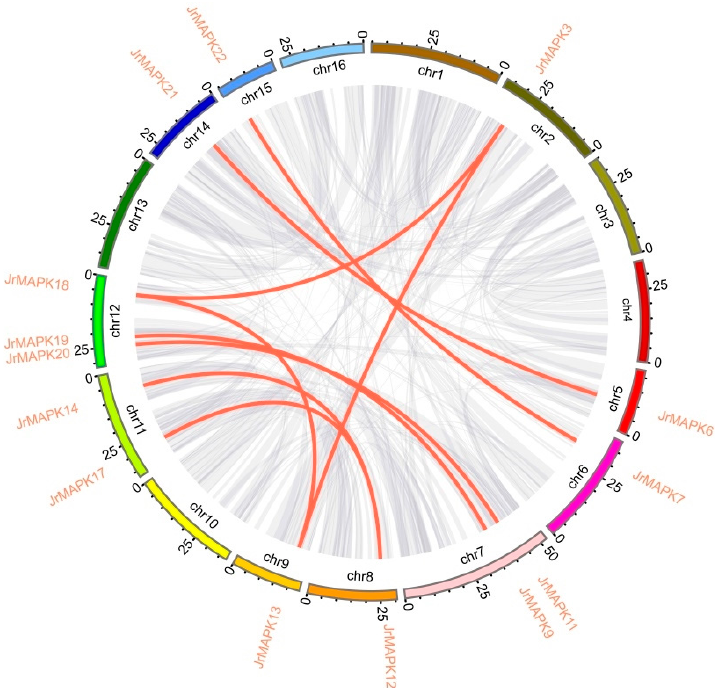
Figure 5. The synteny of MAPK genes in Juglans. Red lines represent segmental duplications of MAPK gene pairs, while gray lines represent synteny blocks in the walnut genome. Each chromosome has an indication of its chromosome number at the